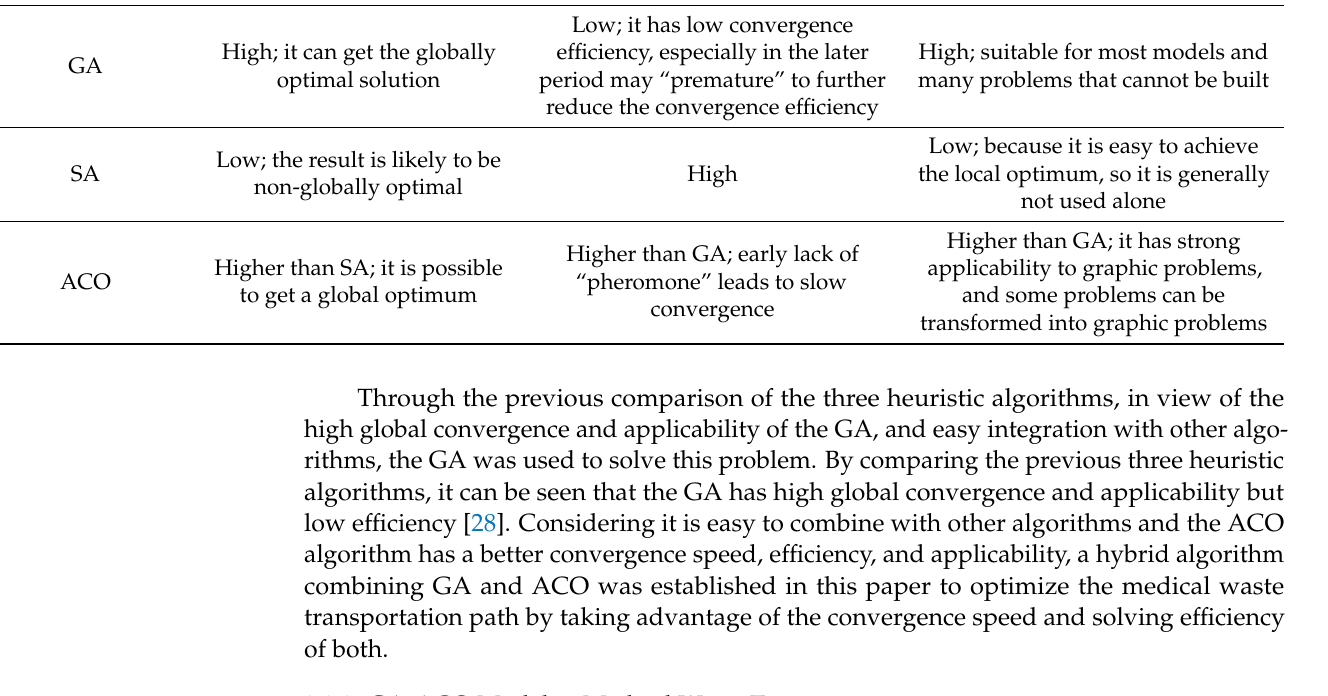
Table 2. Comparison of three algorithms in global convergence, efficiency and applicability.